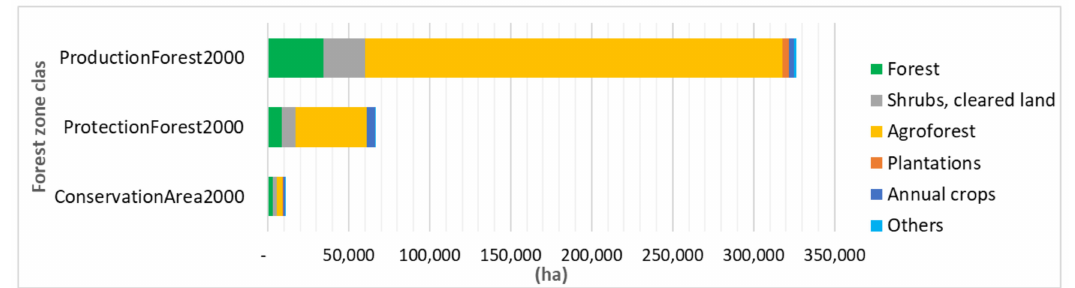
Figure 3. Land cover trajectory (2000) of 2019 agroforest in each Forest-zone class in West Kalimantan (analyzed from [31,32]).